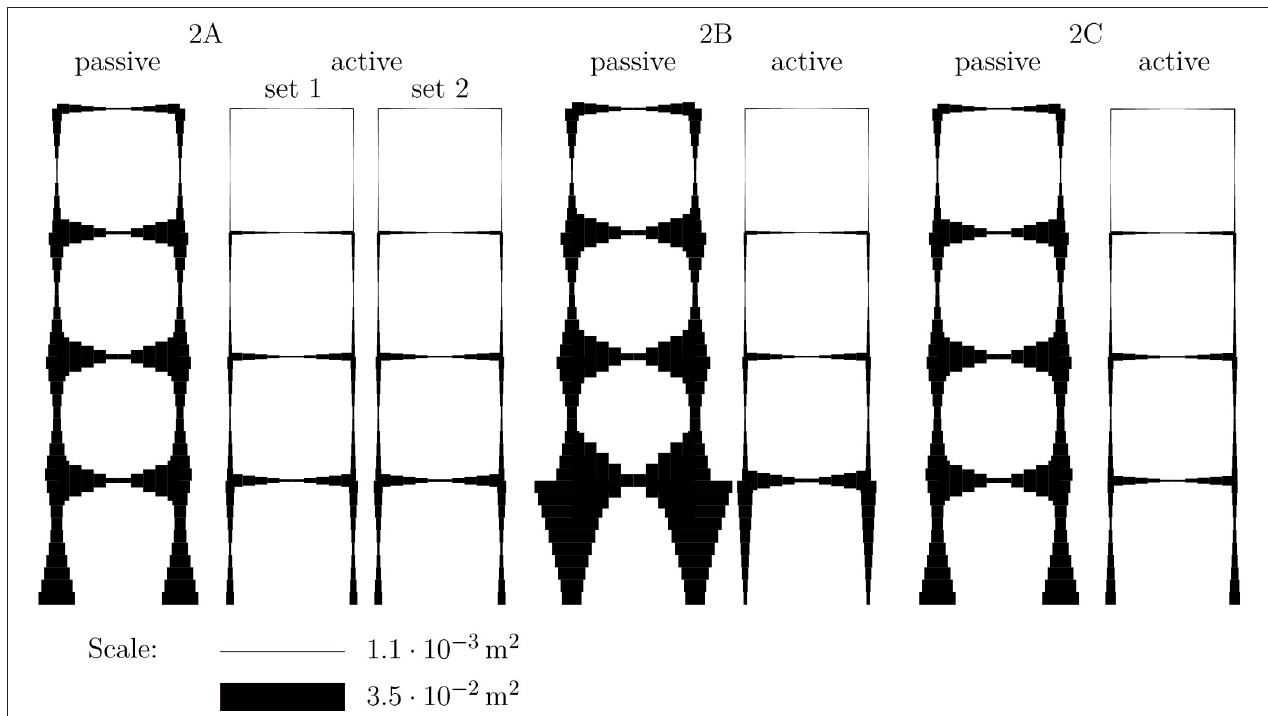
FIGURE 7 | Example 2, frame design: optimized cross-sectional areas.